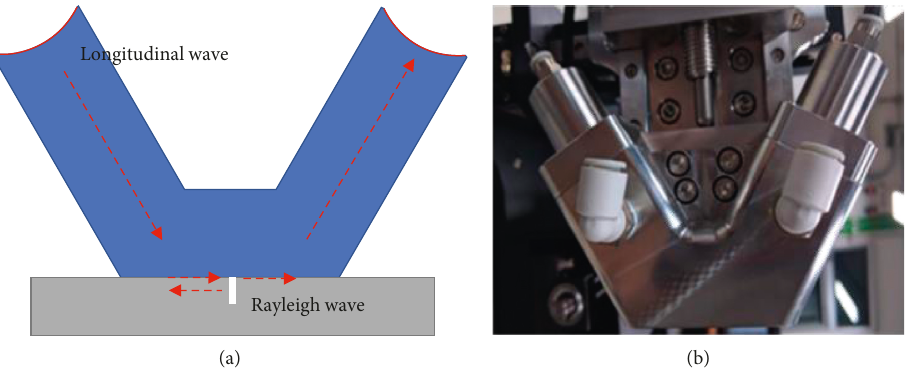
Figure 7: (a) Conceptual diagram and (b) photograph of the ultrasonic sensor